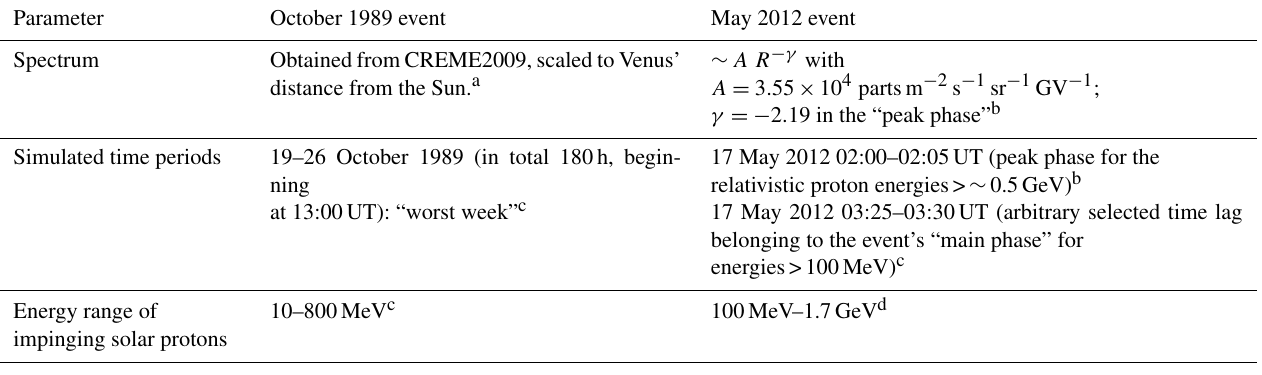
Table 2. Input parameter values used in DYASTIMA during its application to the October 1989 and May 2012 SEP